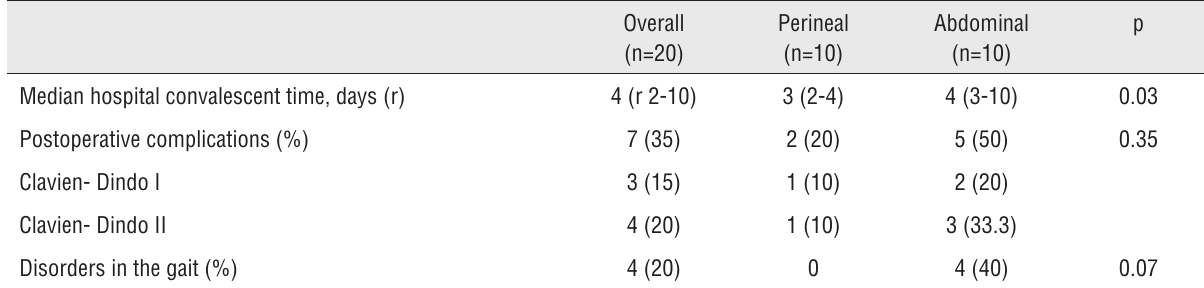
Table 2 - Post operatory data.